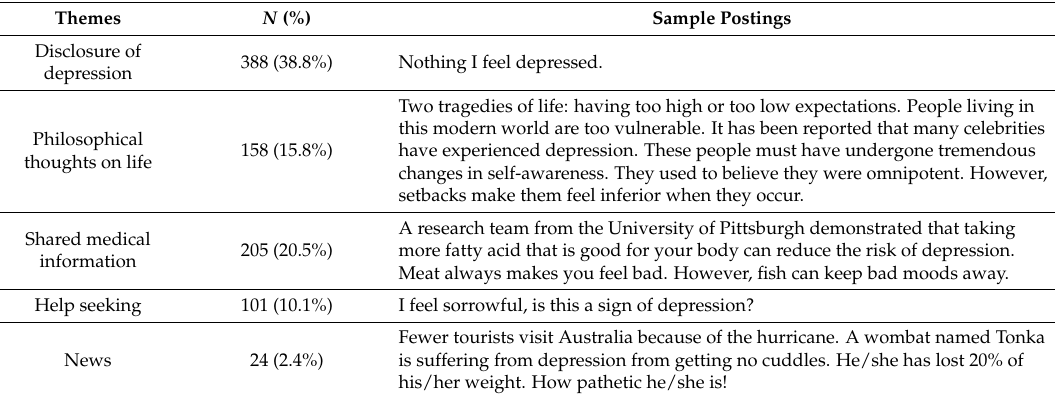
Table 1. Themes of depression-related